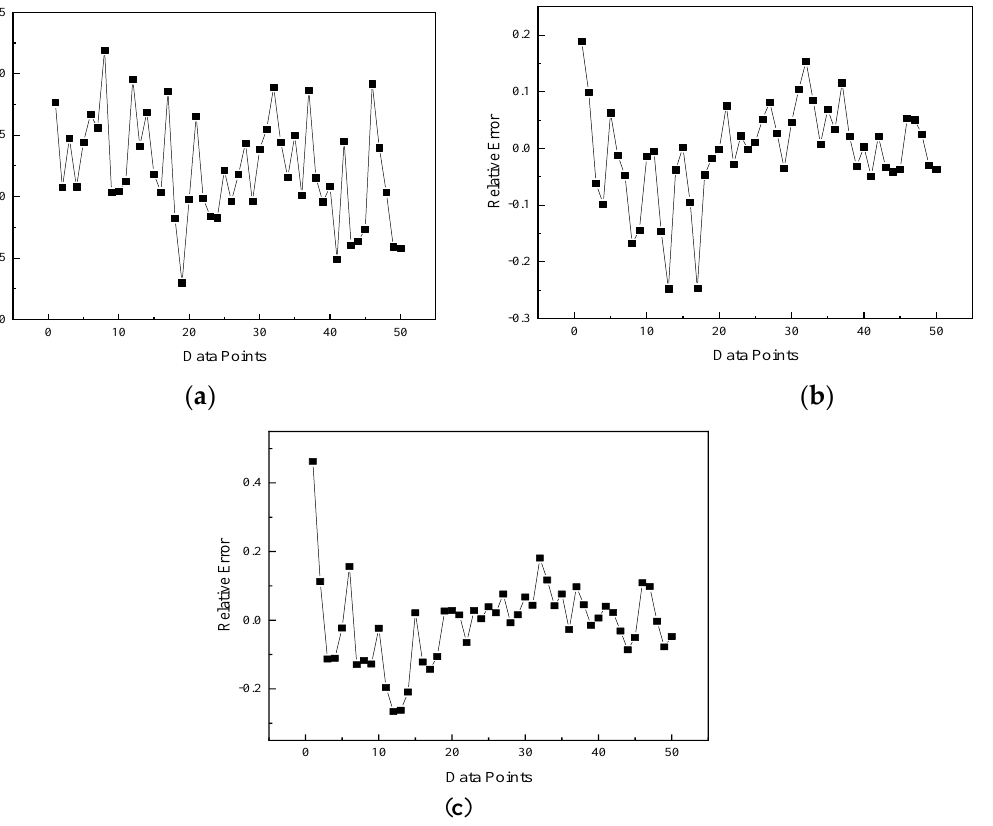
Figure 11. Relative error analysis of the three models: ( a ) the exterior wall; ( b ) the interior wall; ( c ) the interior and exterior wall.